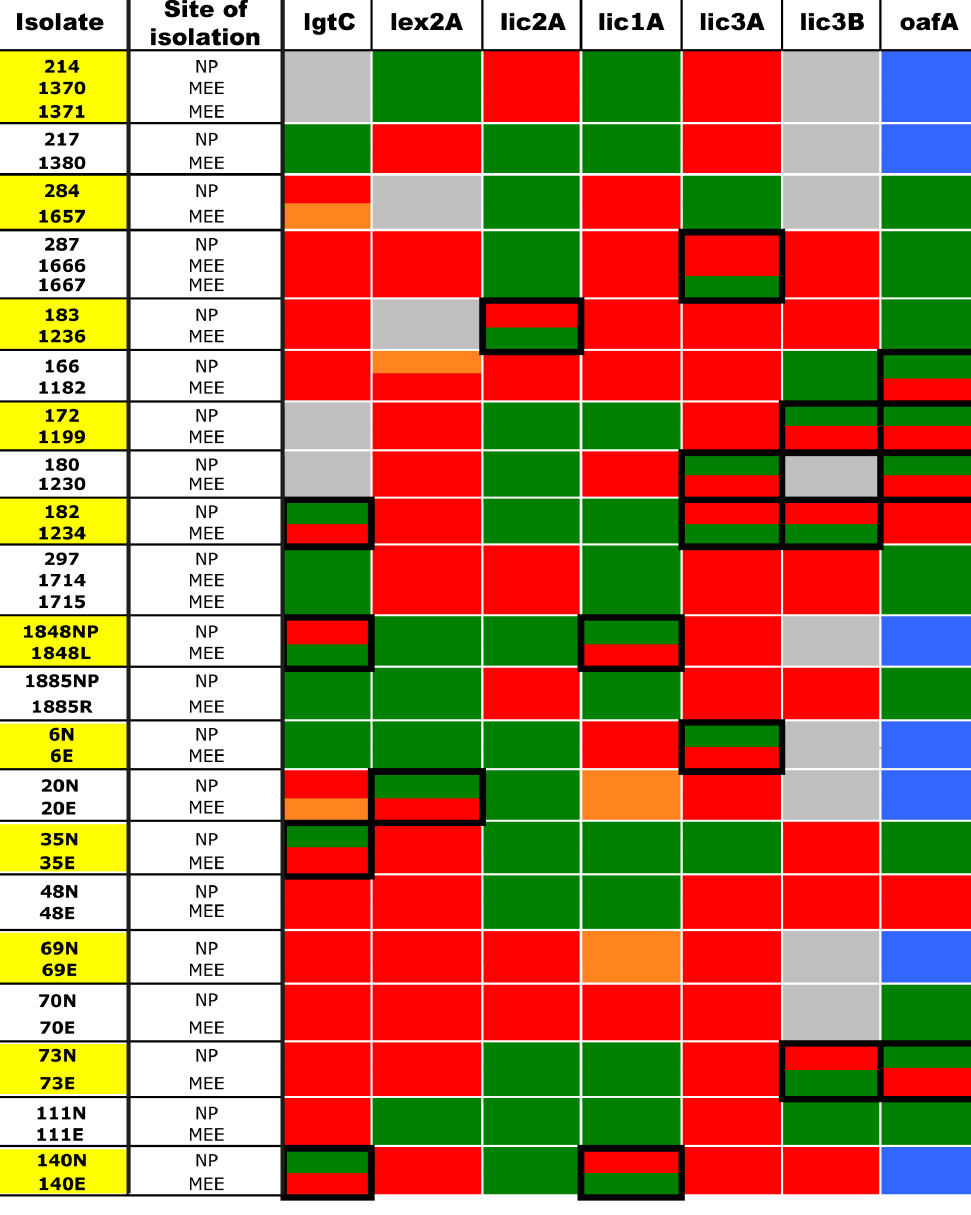
Figure 2. Heat map showing the ON/OFF status of the phase variable LOS biosynthesis genes. Green= . 70% ON; Red= . 70% OFF; Orange=mixed ON/OFF. Switching events are highlighted with a black box. Grey=no gene present; blue=gene is not phasevariable. strain pairs surveyed (29%), and in the case of the OafA acetylase, we observed evidence for consistent selection in multiple subjects (Figure 2).